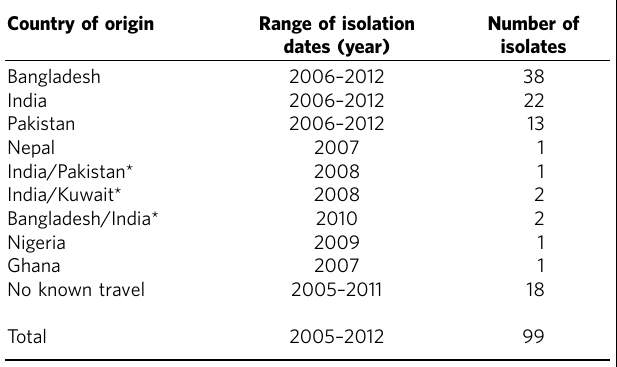
Table 2 | Summary of 99 East London travel-associated S . Typhi isolates used in the study.